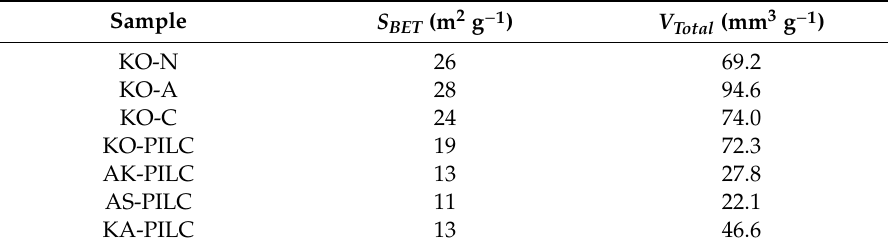
Figure 1. N 2 adsorption isotherms at 77 K of ( a ) pillared clays and ( b ) Kokshetau-based clays. Table 1. Textural properties of the clay-based samples.